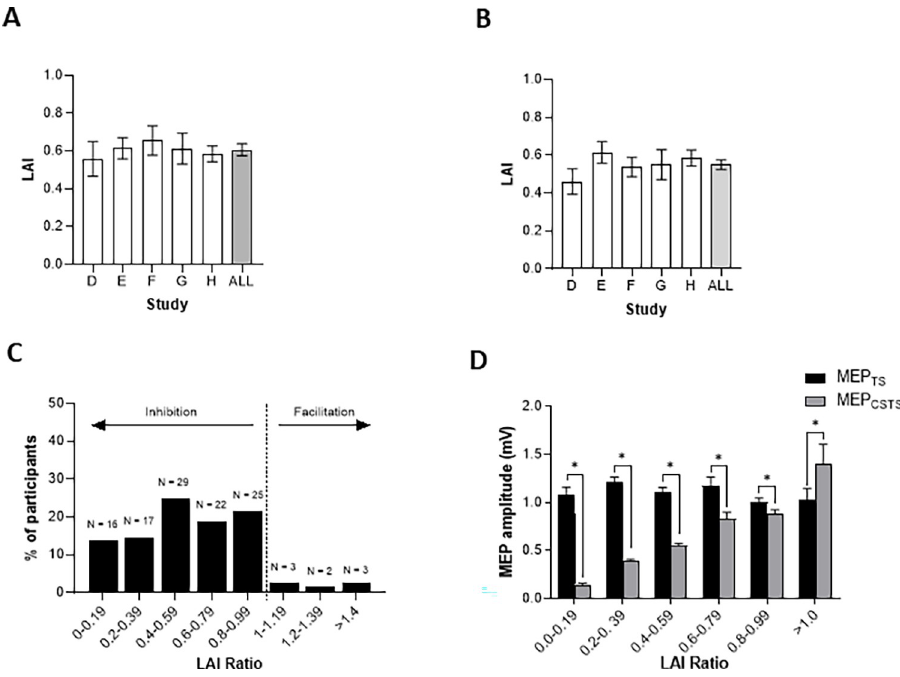
Fig 2. Distribution of LAI data for individual studies and data from all studies. LAI values from each of the studies included in the main analyses are shown with (A; n = 117) and without (B; n = 108) instances where no inhibition occurred. The distribution of pooled LAI data (n = 117) is shown in C, and MEP CSTS and MEP TS amplitudes are shown in D (also n = 117) for 20% bins between LAI = 0 and LAI = 1.0, and for LAI > 1.0. � p < 0.01 significant result of a Mann-Whitney U post-hoc comparison between study A and study H (A). � p < 0.01 significant difference indicated by Wilcoxon signed rank tests and for paired comparisons of MEP CSTS and MEP TS amplitudes within each bin (D). All error bars represent the mean and standard error of the